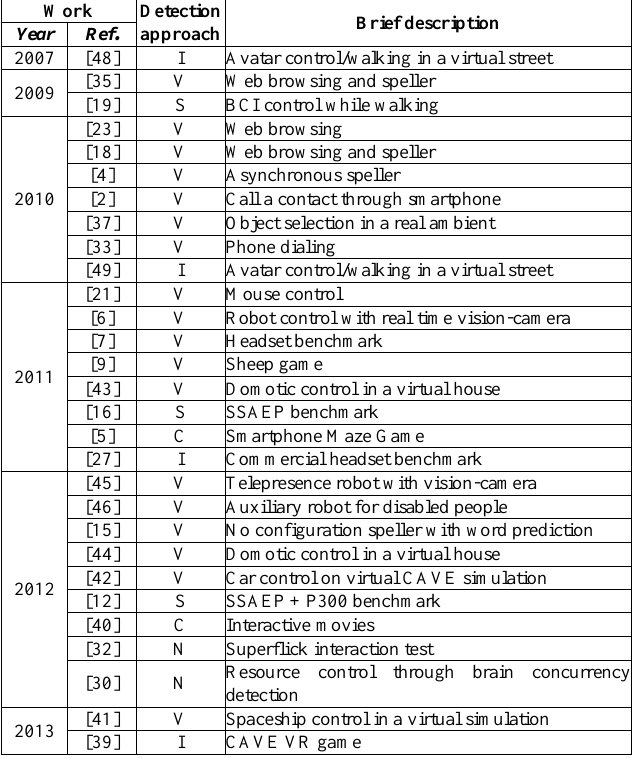
L ITERATURE WORKS PRESENTED IN THIS SURVEY